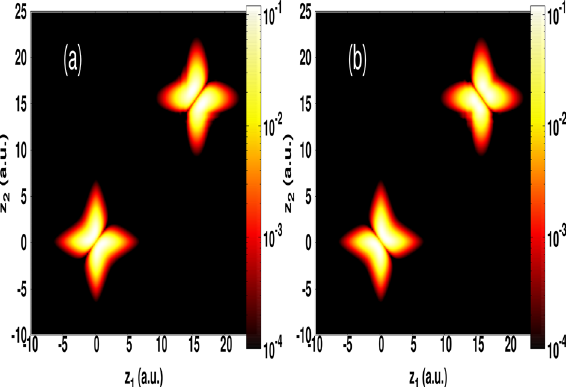
Figure 4. Electron density in z 1 – z 2 plane at the end of the probing single-cycle pulse for calculations from a single spin state ( a ) and the triplet spin case ( b ) of helium atom. The peak intensity is 7 10 23 W/cm 2 and the angular frequency is 9.2 a.u. For reference, the initial states before applying the probing pulse are shown at the